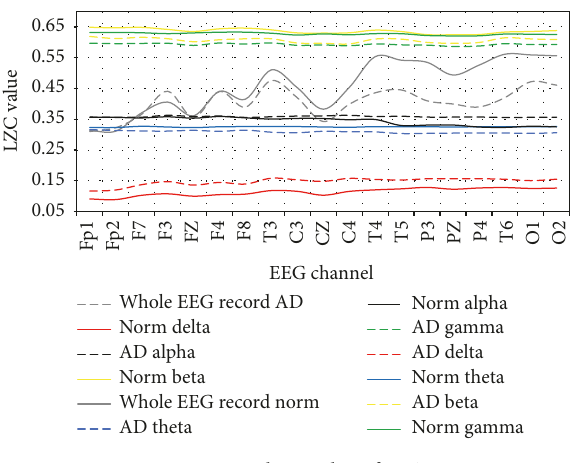
Figure 4: EEG biomarkers for LZC.